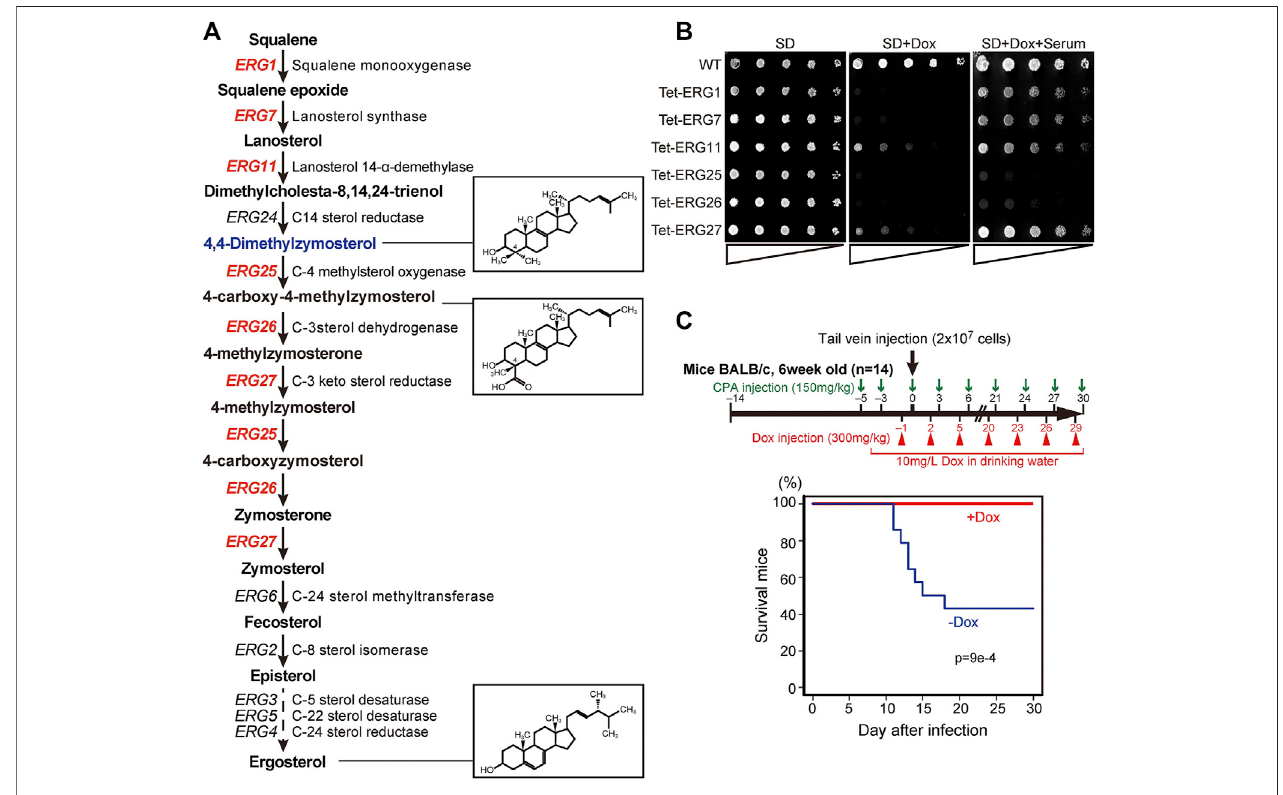
FIGURE 1 | ERG genes and the effects of knockdown. (A) Biosynthetic pathway from squalene to ergosterol, including genes, enzymes, and metabolic intermediates. Twelve genes encode enzymes of the ergosterol biosynthetic pathway in S. cerevisiae ; the six genes in red are essential for growth in S. cerevisiae , in the absence of exogenous ergosterol. The chemical structures of ergosterol and 4, 4-dimethylzymosterol are indicated in the boxes to the right. (B) Effect of serum supplementationincellssubjectedtogenerepression.Wild-type(HETS202)andTet-ERGcellsinwhichtheindicated ERG genesareknockeddownbyDoxdiluted to OD 600 (an optical density at 600 nm) of0.5 in water. The diluted cells were spotted in 4-fold serial dilutions as indicated by triangles on agar plates of minimal medium (SD), SDcontaining20 μ g/mlDox(SD+Dox),orSDcontaining20 μ g/ml Doxand 10%serum (SD+Dox+Serum),andincubatedfor24 hat37 ° C.Theexperimentwas conducted three times. (C) Survival rate of mice after infection with Tet-ERG25 cells. As shown in the fl owchart (upper panel), mice were dosed with 150 mg/kg body weight of cyclophosphamide (CPA) 3 and 5 days before the infection, and every 3 days after infection until the end of the experiment. The mice also were injected intraperitoneallywithDoxinPBS(300 mg/kgbodyweight)every3 daysstarting1 daybeforetheinfectionandalso providedwithdrinking watercontainingDox(10 mg/ L) from starting from 4 days before infection. Log-phase Tet-ERG25 cells (2 × 10 7 yeast cells/animal) were administered to mice by tail vein injection. Red and blue lines indicate the survival rates of mice for the Dox-treated and Dox-untreated groups, respectively ( n = 14 each). Vertical and horizontal axes indicate percentage of mice still alive and days after infection, respectively. p values were calculated using the log-rank (Mantel-Cox) test.